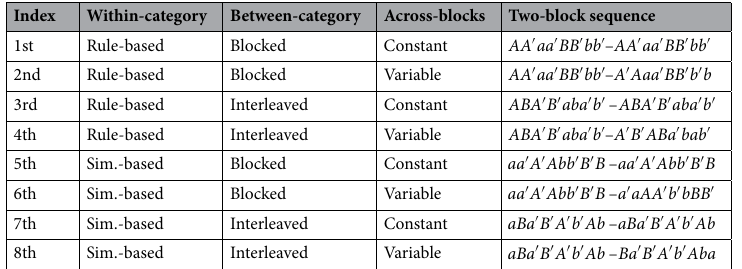
′ ′ ′ , A , and A ) or Category B (letters b , b ,